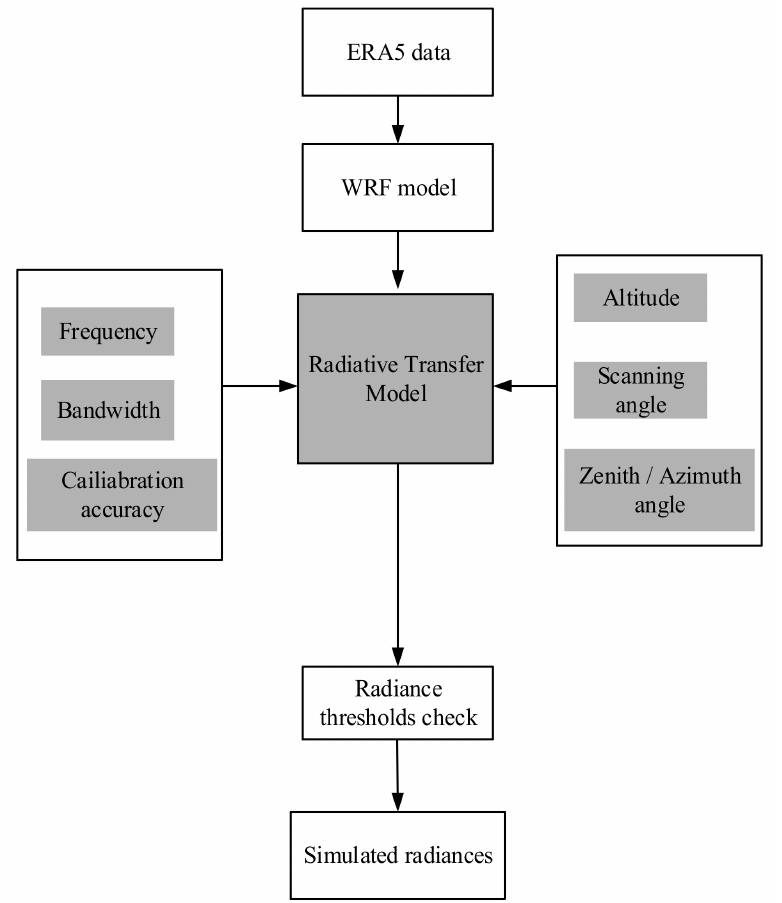
Figure 2. Framework of the geostationary microwave sounder (GEOMS) radiances simulating system.